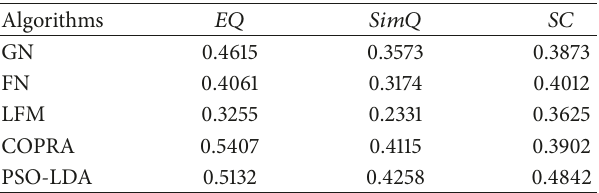
Table 2: The classical nonsemantic algorithms on 𝐸𝑄 , 𝑆𝑖𝑚𝑄 , and 𝑆𝐶